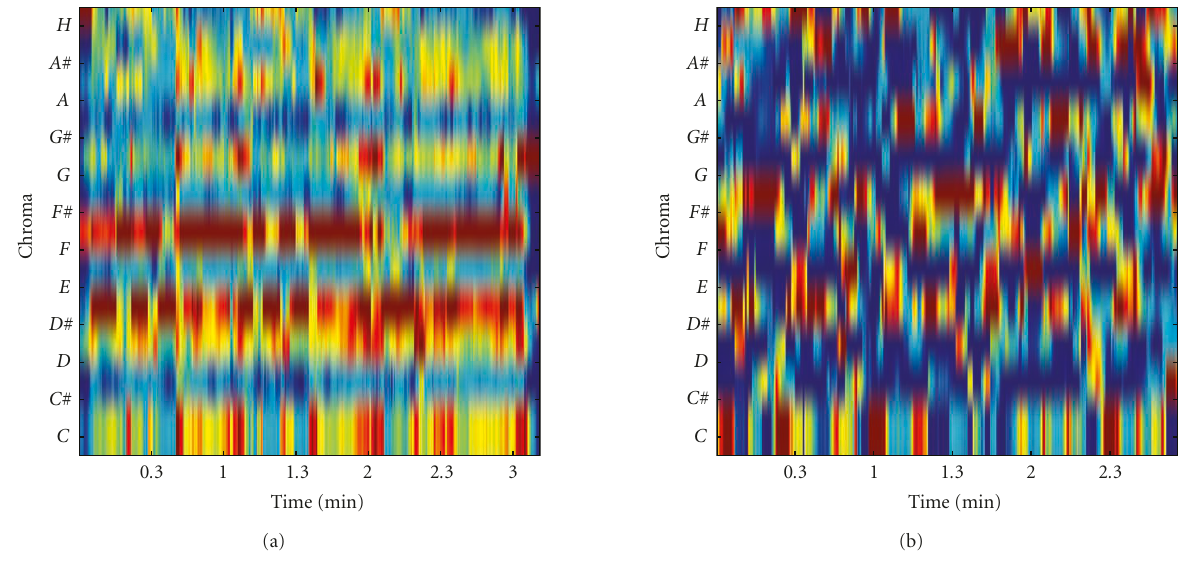
Figure 3: Chromagram: chroma calculated using the GWS of (a) Whenever, Wherever and (b) All of Me